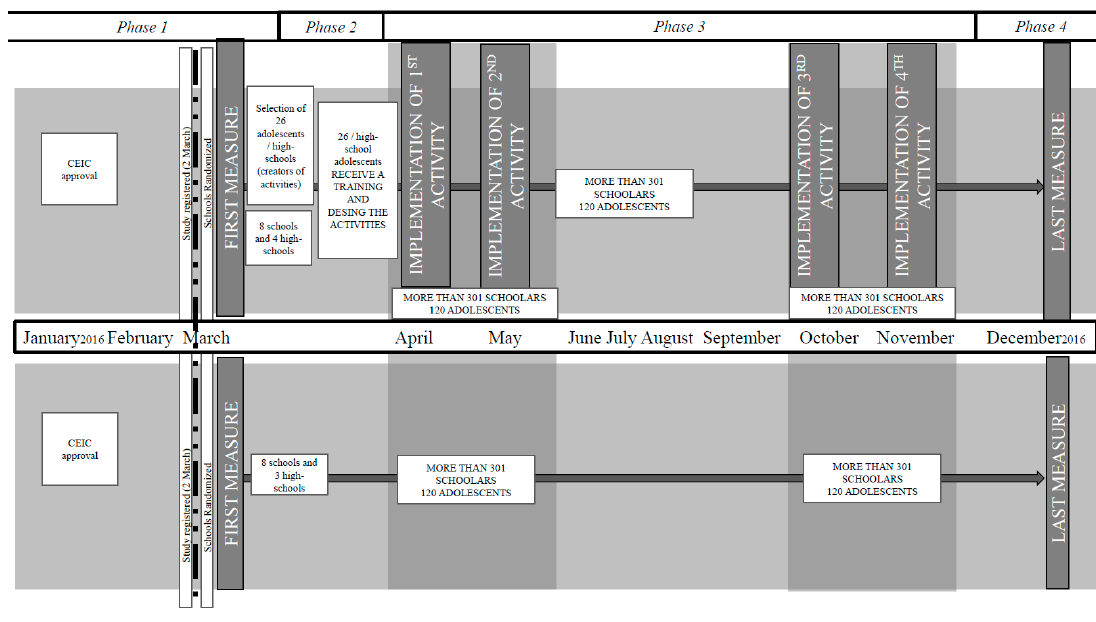
Figure 1. Intervention schedule for the EYTO-kids (European Youth Tackling Obesity in Adolescents and Children) project.